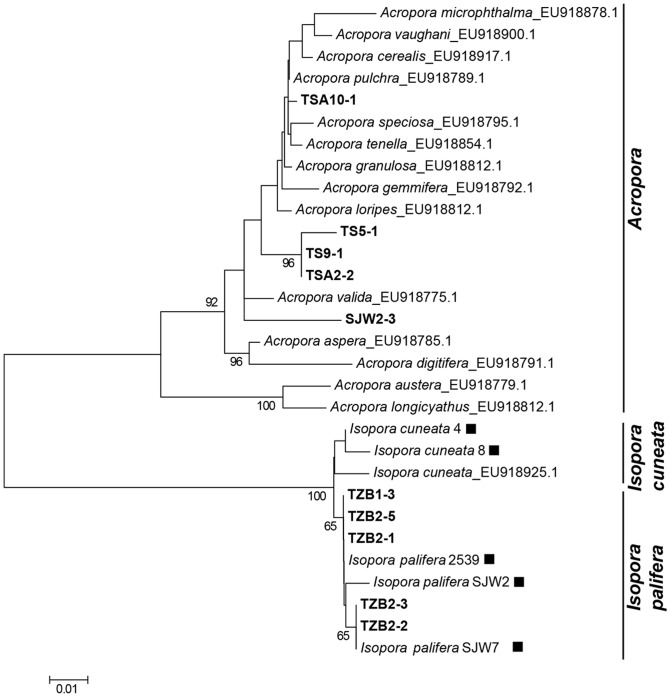
NJ tree of PaxC sequences for Acropora/Isopora identification.(A) Neighbor-joining tree of PaxC constructed by Tamura three-parameter model with 1000 bootstrap replications. The sequences of coral spat and reference corals in this study are labeled in bold and filled squares, respectively. All other PaxC sequences are from reference [67].